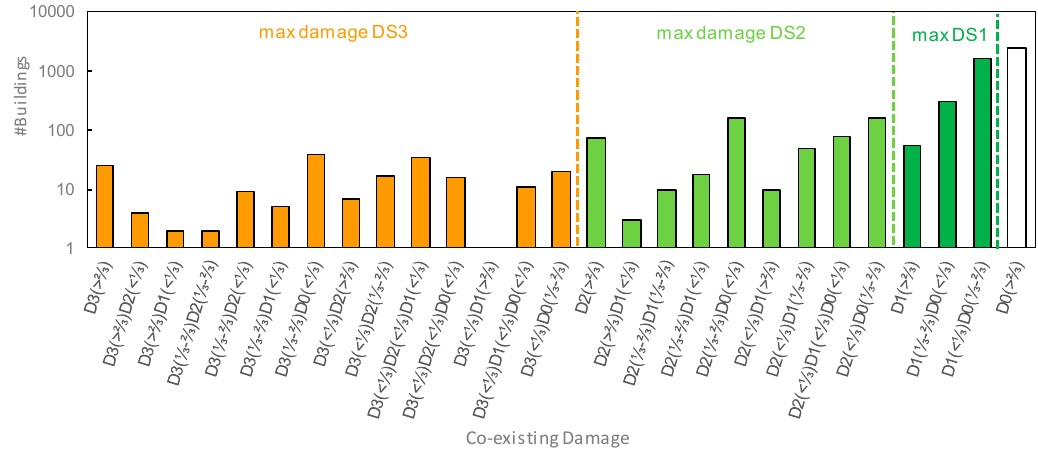
Figure 9. “Coexisting” damage given the maximum damage level (Number (#) of buildings is in logarithmic scale).